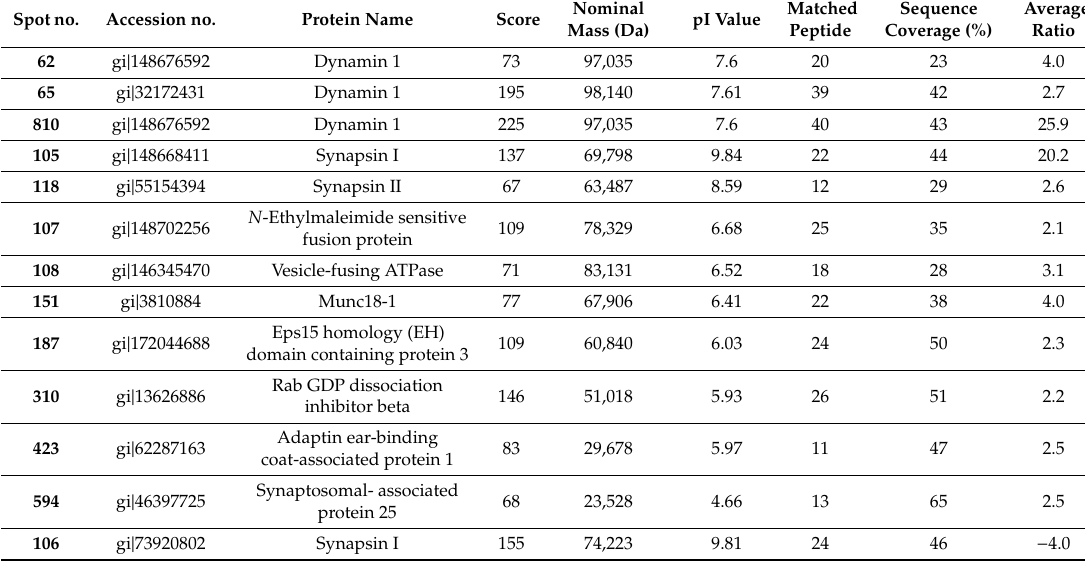
Table 1. Di ff erentially expressed proteins related to vesicular tra ffi cking after entacapone treatment in the